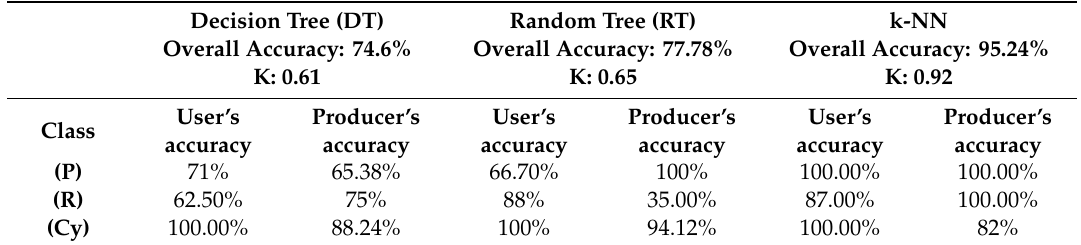
Table 5. Accuracy assessment for the DT, k-Nearest Neighbors’ algorithm (k-NN) and RT supervised classification algorithms (very shallow water area).